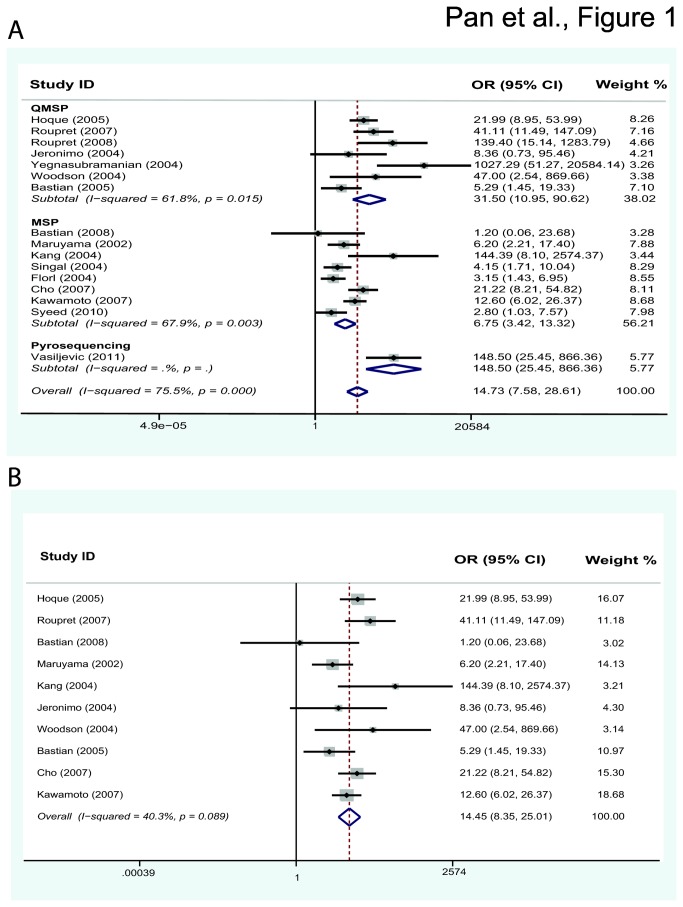
Forest plot showing the association between RASSF1A methylation and prostate cancer.(A) Forest plot of 16 studies showed that RASSF1A methylation was associated with PCa risk as stratified analysis by methods. (B) Forest plot after sensitivity analysis removing 6 studies showed the same risk without heterogeneity (p= 0.089). The diamond symbol represents the overall estimate from the meta-analysis and its CI (confidence interval), while its center is positioned on the value for the overall effect estimate. Diamond’s width depicts the width of the overall CI.